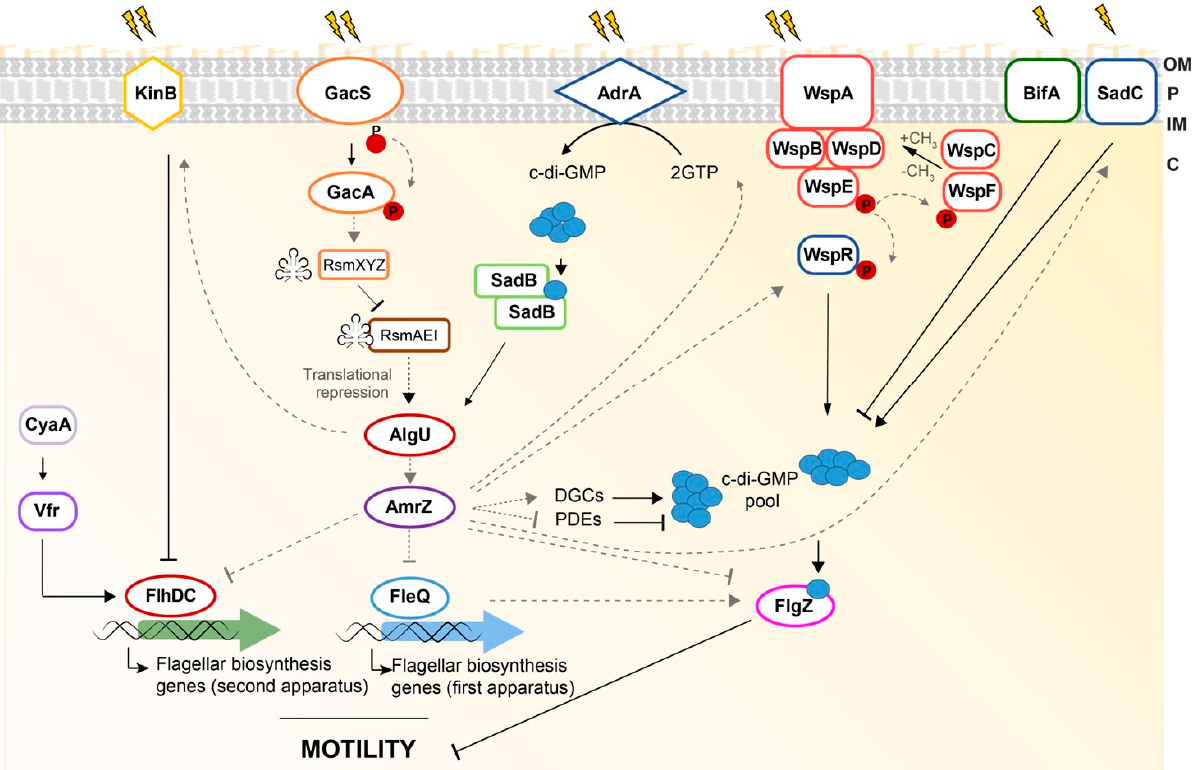
Figure 3. Current model for motility environmental regulation in Pseudomonas ogarae F113. Several pathways have been identified in the regulation of motility in this bacterium. Blue circles represent c-di-GMP molecules. Gray dashed lines indicate transcriptional regulation, whereas regular black lines represent other levels of regulation. P depicts phosphate. Ray shapes represent environmental stimuli. Small RNA encoded by rsmXYZ and titrated by RsmAEI is drawn close to the Rsm boxes. C: cytosol; IM: inner membrane; OM: outer membrane; P: periplasm.